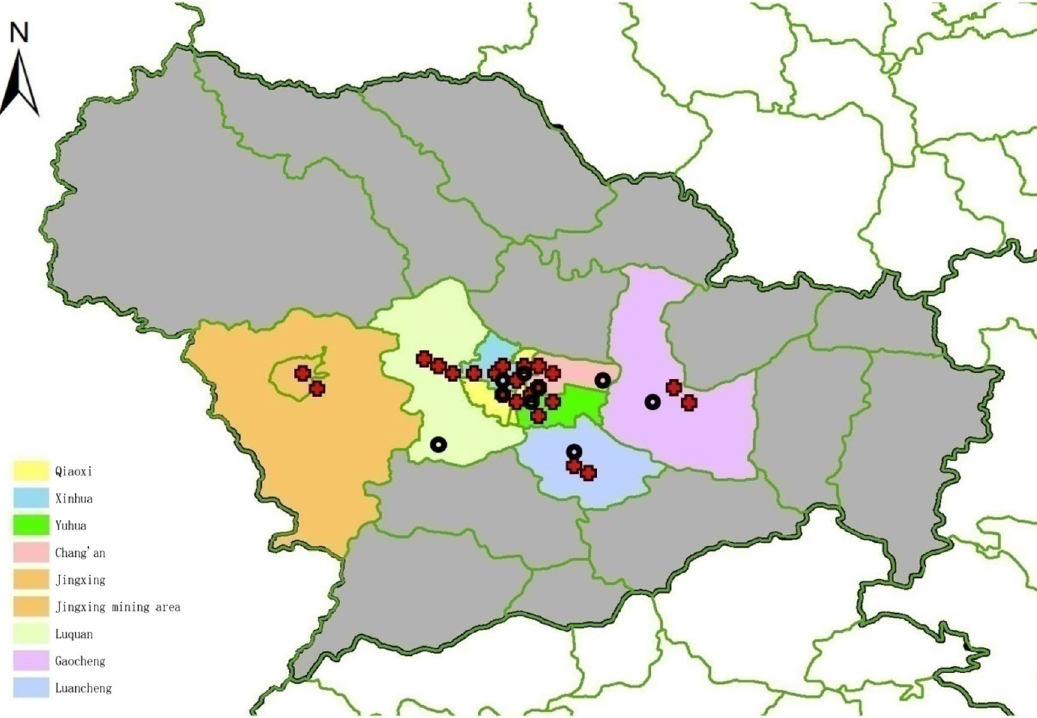
Figure 1. The geographical location of hospitals (red crosses denoting public tertiary hospitals and secondary hospitals) and air quality monitoring stations (black circles) in Shijiazhuang. (ArcGIS 10.2 for Desktop software, Environmental Systems Research Institute Inc., USA, https:// www. esri.